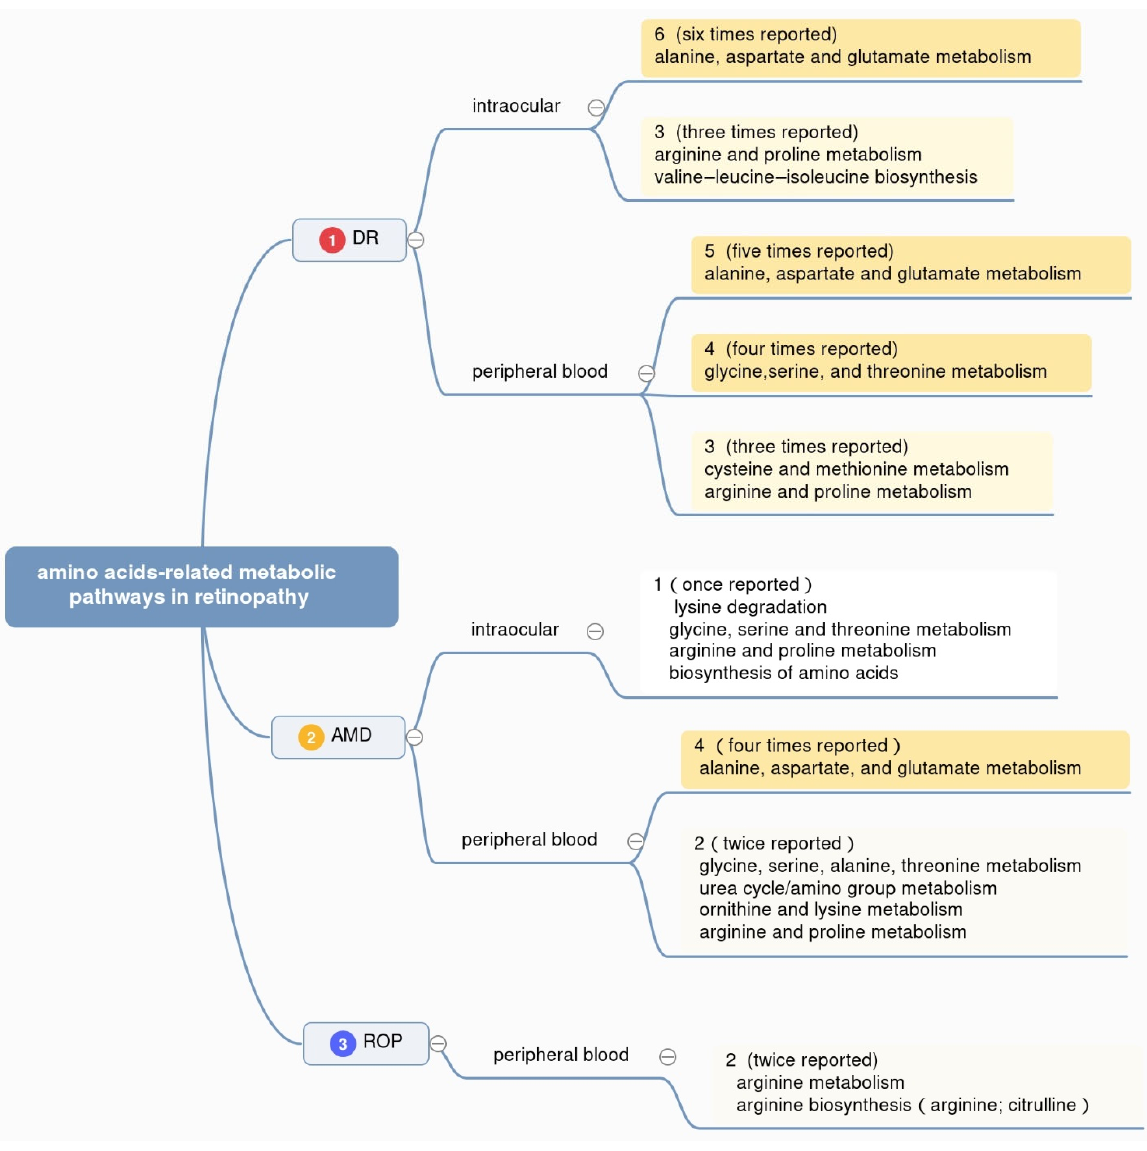
Figure 3. Amino acid ‐ related metabolic pathways in three types of retinopathy. The figure displays the top 30% enriched pathways associated with amino acids in retinopathy, ranked by the reported frequency with different colors.